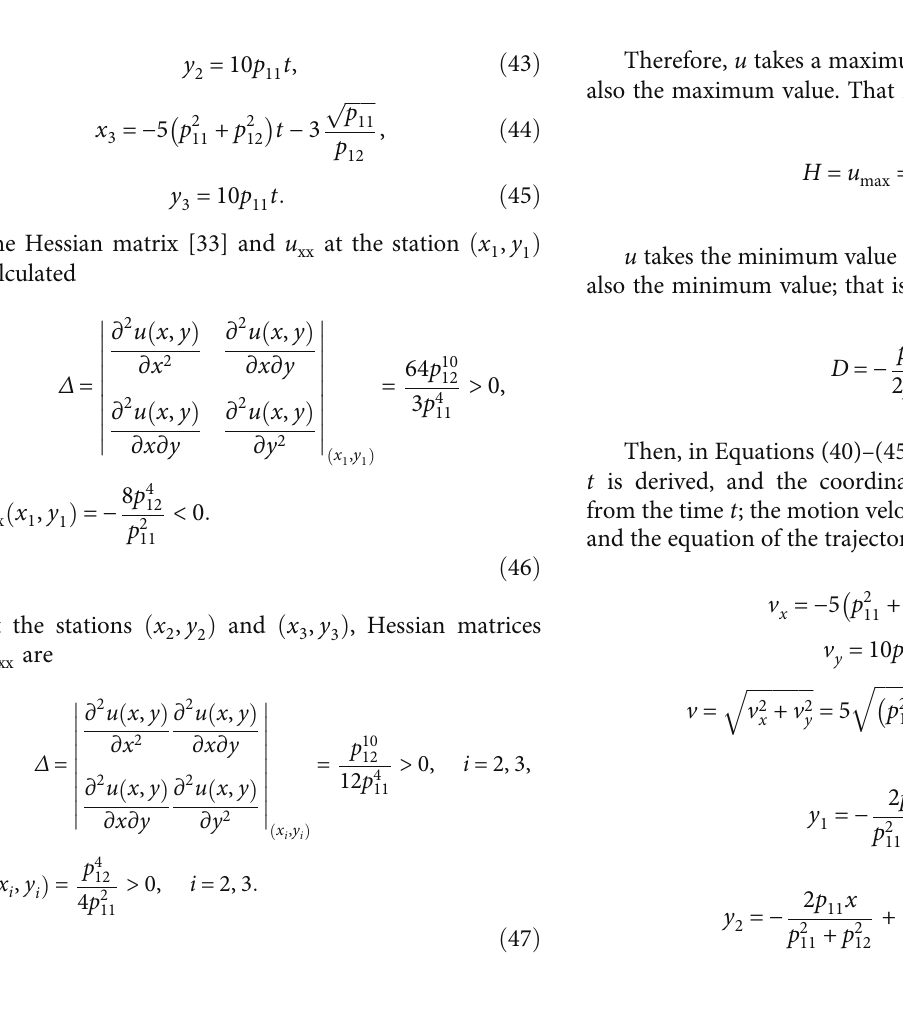
Figure 4: 1-Lump solution ð p